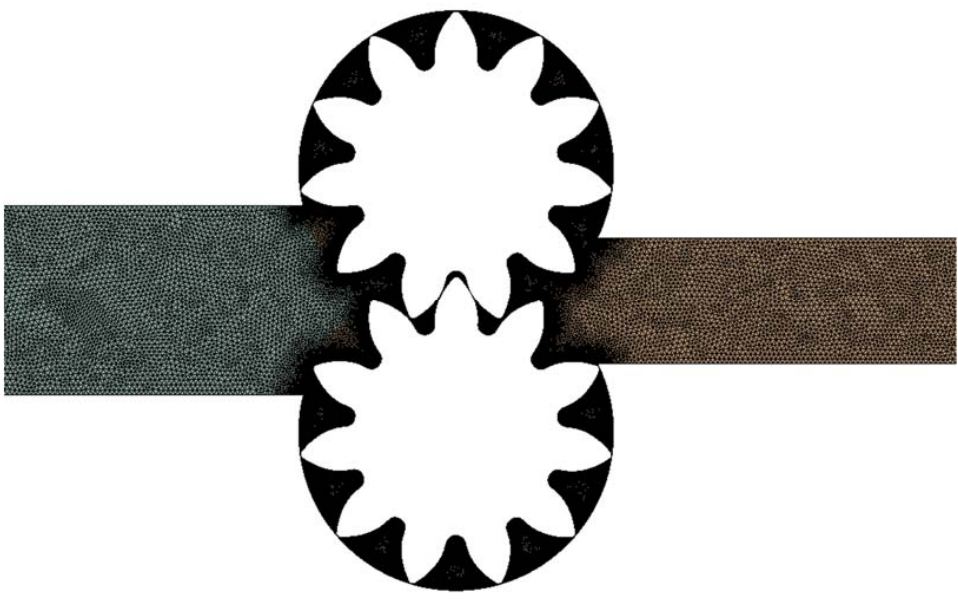
Figure 4. Meshed pump model.